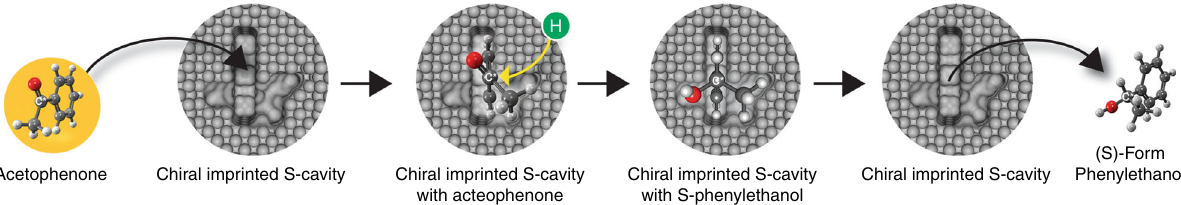
Fig. 4 Enantioselective synthesis steps. Illustration of the electrosynthesis of (S) -phenylethanol from acetophenone based on its adsorption in chiral- imprinted cavities of the mesoporous metal, followed by its stereoselective reduction and